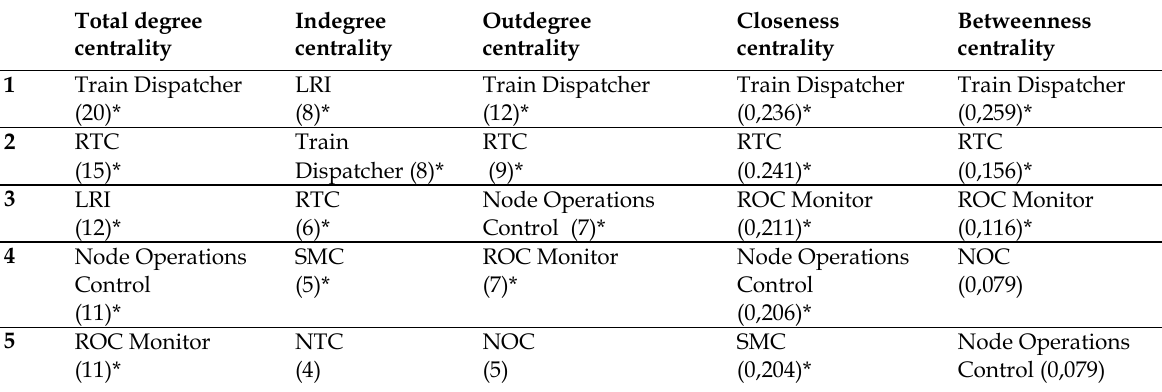
Table 4. The most central nodes based on degree, closeness and betweenness centrality measures